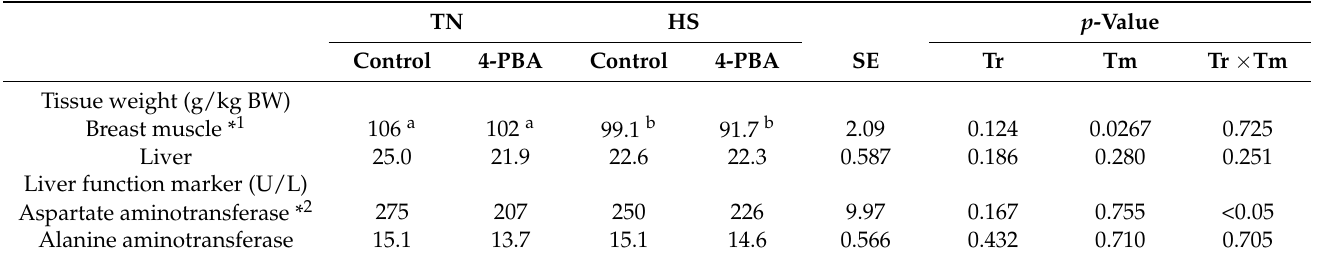
Table 3. Average body weight (g), feed conversion ratio (FCR), and tissue weight (g/kg BW). TN HS p -Value